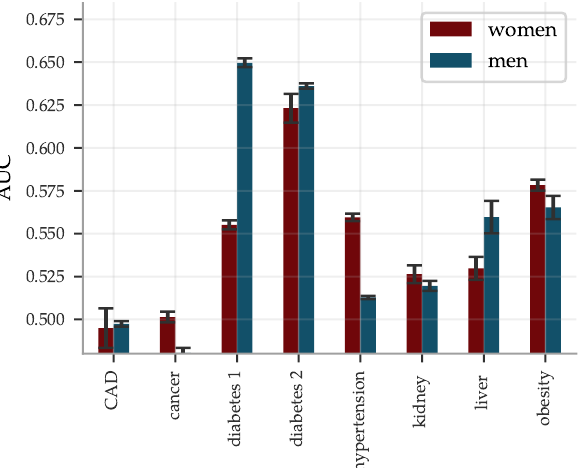
Figure 8. AUCs for gBMRS predictors drop significantly as compared to BMRS in Figure 6 and only the diabetes predictors reach par with other methods. The predictors were evaluated on 9016 (9606) white women (men) and the error bars indicate ± the standard deviation for 5 different